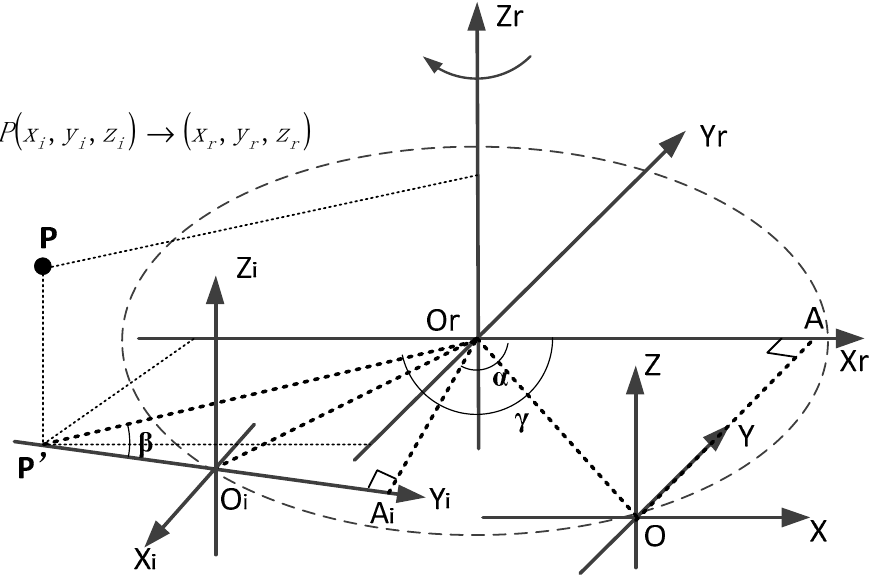
Figure 2. The transformation between the coordinate system of the LSL module and the coordinate system of the self-rotating, LSL scanning, 3D reconstruction system.